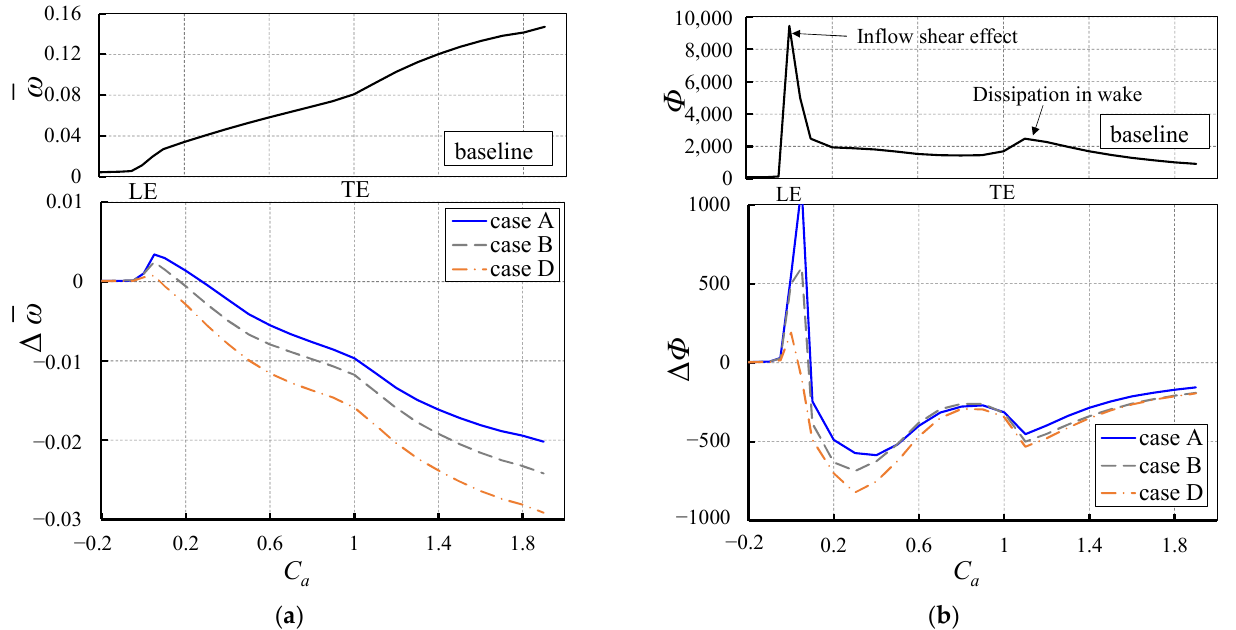
Figure 17. Development of loss in the passage at the near-stall point. ( a ) Development of mass-flow- rate-weighted  ; ( b ) development of area-averaged Ф .